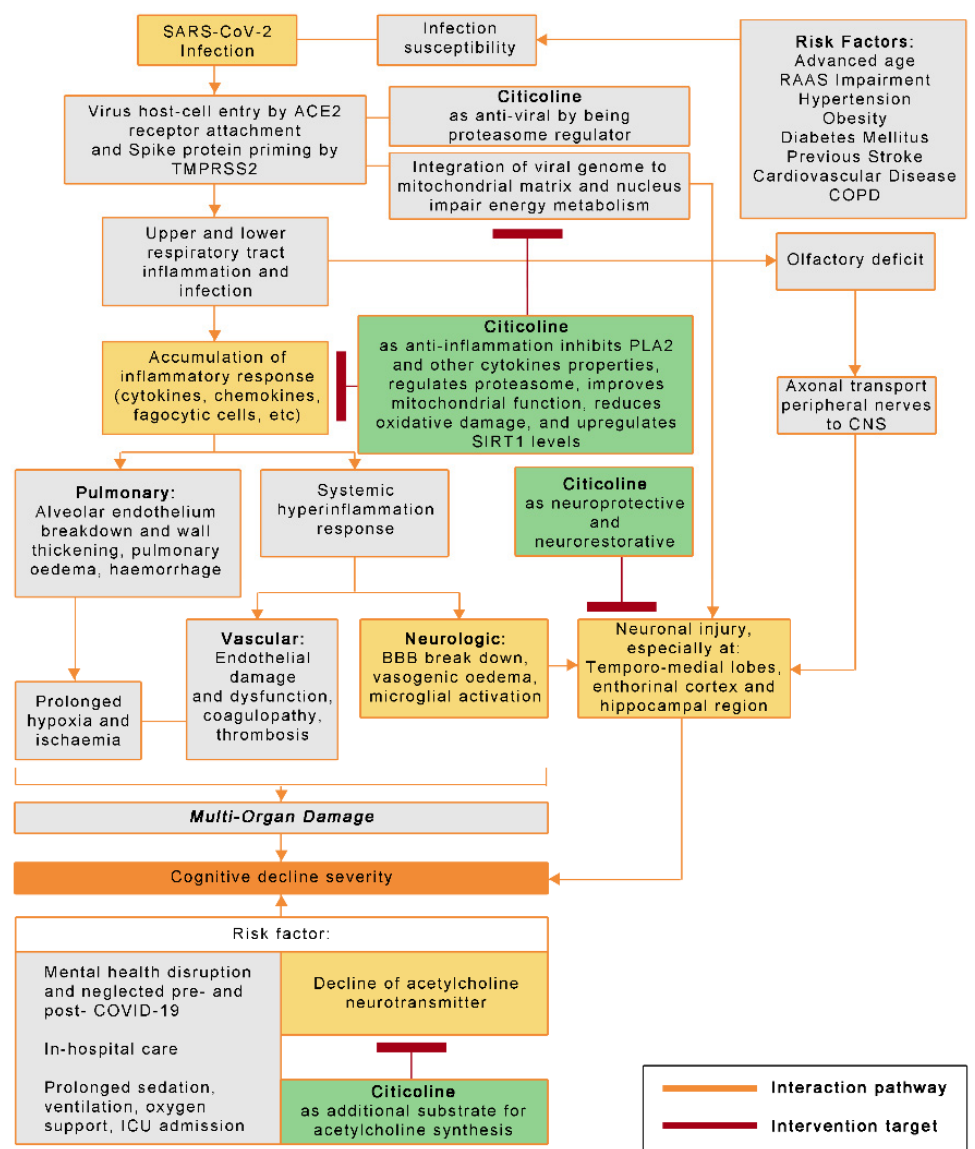
Figure 1. The role of citicoline in COVID-19 pathophysiology towards cognitive and other neurologic complications. Notes: ACE2 receptor (Angiotensin Converting Enzyme 2 receptor); BBB (Blood–Brain Barrier); CNS (Central Nervous System); COPD (Chronic Obstructive Pulmonary Disease); PLA2 (Phospholipase 2); RAAS (Renin-Angiotensin-Aldosterone-System); TMPRSS2 (Transmembrane Serine Protease 2).